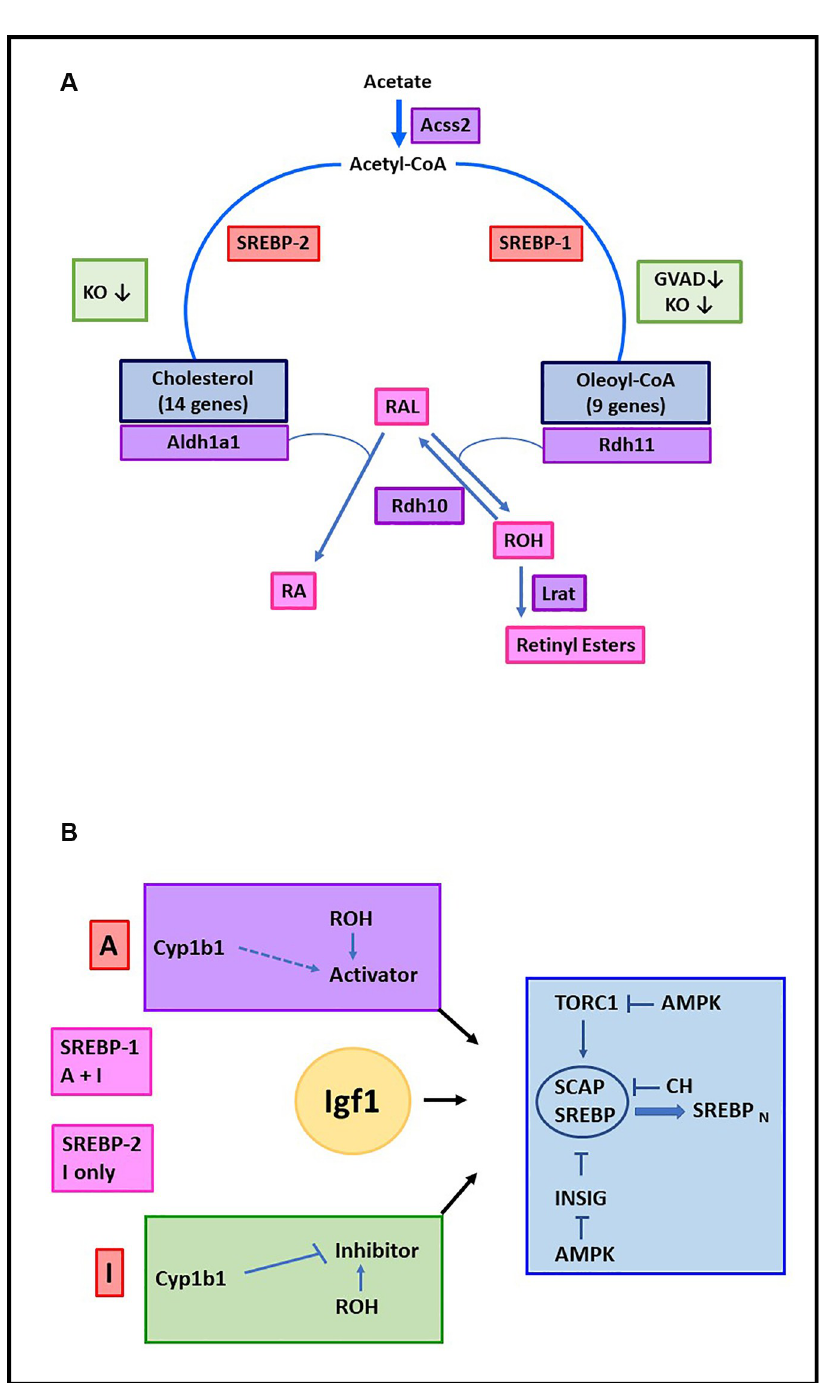
Fig 9. Dual Cyp1b1/retinol regulation of Srebp-1c/oleate and Srebp2/cholesterol pathways in postnatal liver. Pathways that convert acetate to cholesterol or oleoyl-CoA and retinaldehyde to RA or retinyl esters. All processes are inhibited in Cyp1b1-/- pups (KO) (Table 1). Srebp2/cholesterol pathway genes and Aldh1a1 show no effect of GVAD in WT pups. The Srebp-1/oleoyl-CoA pathway genes show losses with GVAD treatment of WT pups. The retinaldehyde is formed in the liver from β -carotene by Bco1. The reductase, Rdh11, which regenerates retinol, follows the Srebp1 pattern. This step, followed by Lrat, generates retinyl esters in stellate cells. Aldh1a1 is the major means to convert retininaldehyde to RA (A). Distinctive Cyp1b1 –retinol partnerships for Srebp1 and Srebp2 during stimulations by Igf1. Inhibition Pathway (I): Cyp1b1 removes/metabolizes the mediator of an inhibitory pathway, which becomes active in Cyp1b1-/- pups. Retinol supports this inhibitory pathway, leading to stimulation with